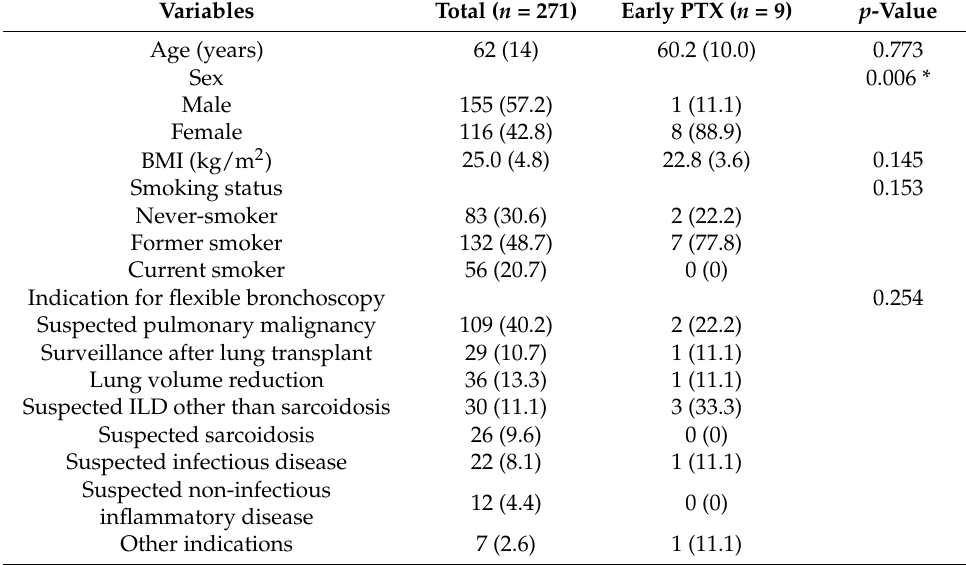
Figure 2. Study flowchart. LUS, lung ultrasound; PTX, pneumothorax; CXR, chest X-ray. Table 2. Baseline characteristics.